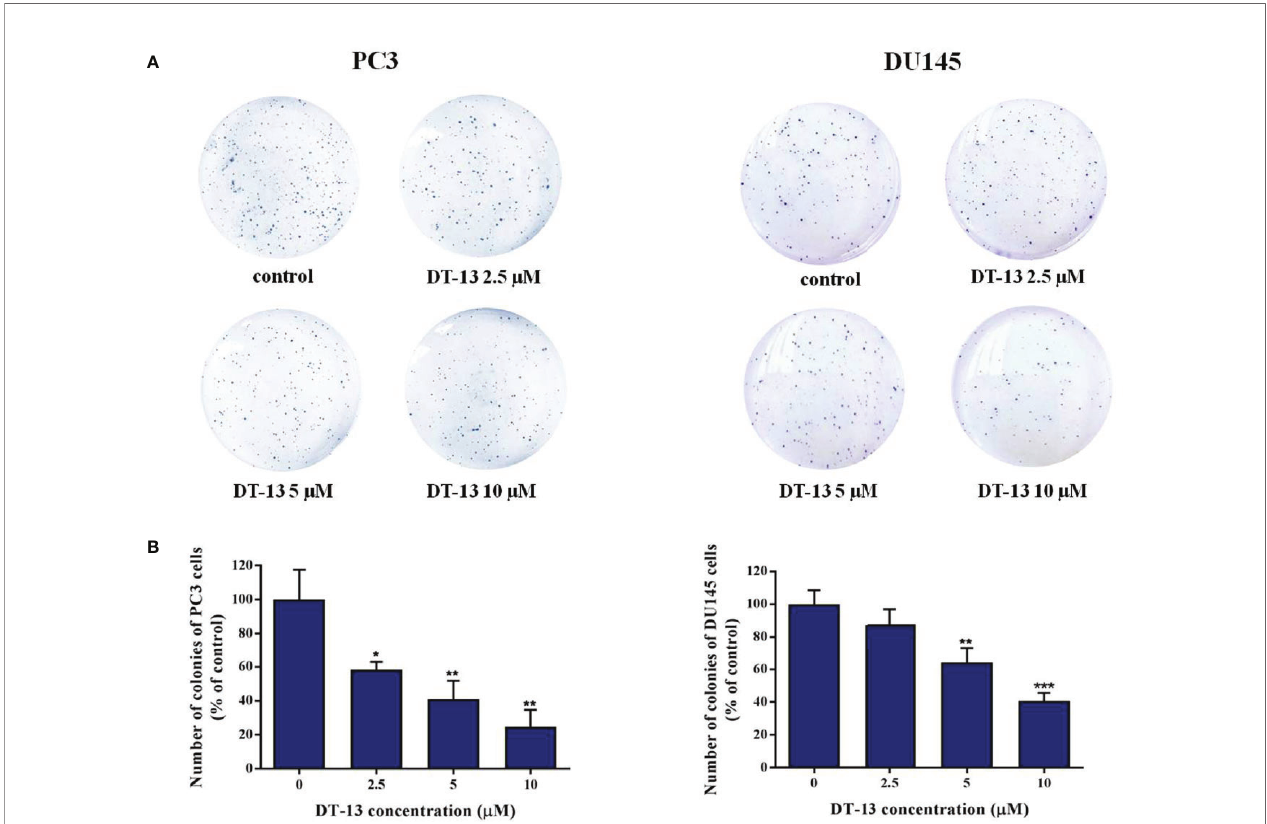
FIGURE 2 | Effect of DT-13 on colony formation capability of prostate cancer cells. (A) Clonogenic assay was carried out to assess the effect of DT-13 on the colony formation capability of PC3 and DU145 cells. After treatment with 0, 2.5, 5, and 10 m M of DT-13 for 48 h, cells were incubated in agarose plates for 14 days and then stained with crystal violet. (B) The histograms represent the number of colonies of PC3 and DU145 cells following treatment with DT-13, compared to those of control cells. Data are mean ± SD (n = 3), representative of three independent experiments. * P < 0.05, ** P < 0.01, ***P< 0.001, compared with